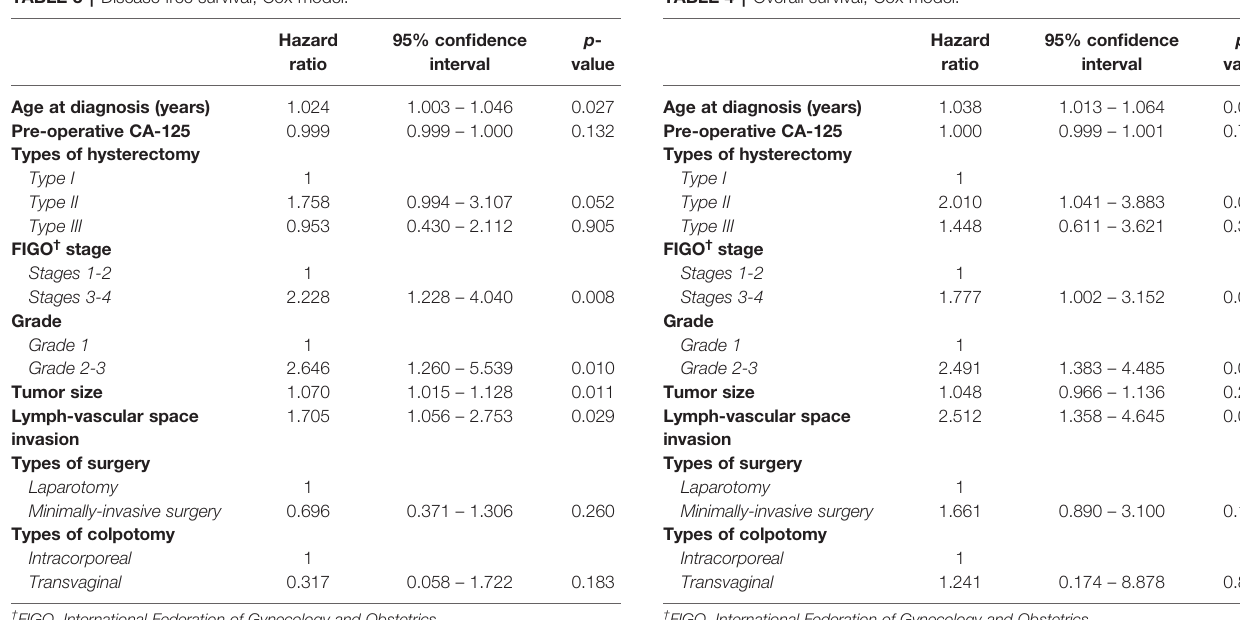
TABLE 3 | Disease free survival, Cox model.